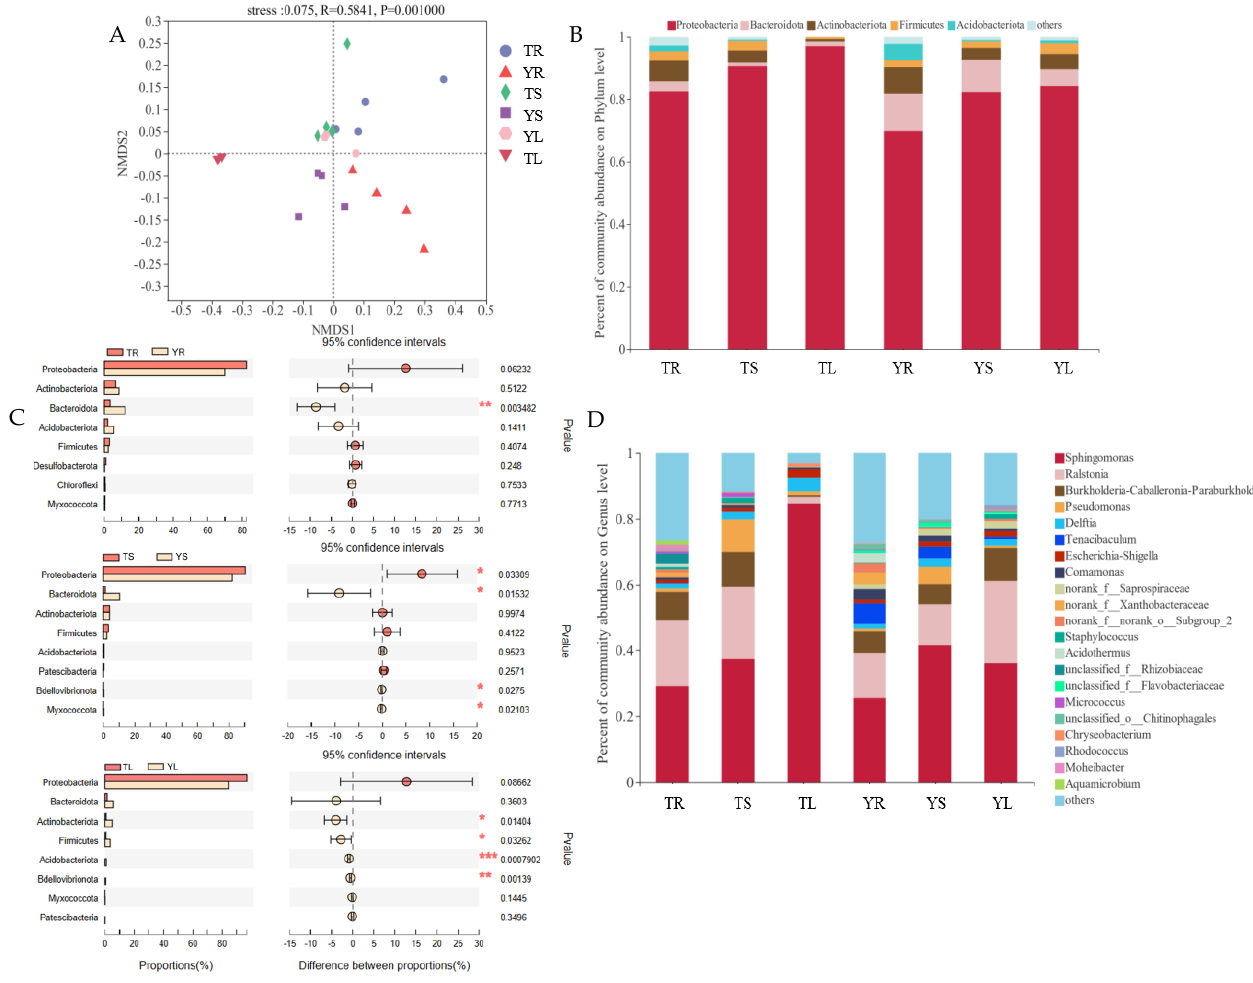
Figure 1. The composition of endophytic bacterial community in the castor. ( A ) The NMDS analysis of endophytic bacterial community; ( B ) Relative abundance of the endophytic bacterial community at phylum level; ( C ) Comparison of the relative abundance of endophytic bacteria between the same tissues at phylum level (* 0.01 < p ≤ 0.05, ** 0.001 < p ≤ 0.01, *** p ≤ 0.001); ( D ) Relative abundance of the endophytic bacterial community at genus level.